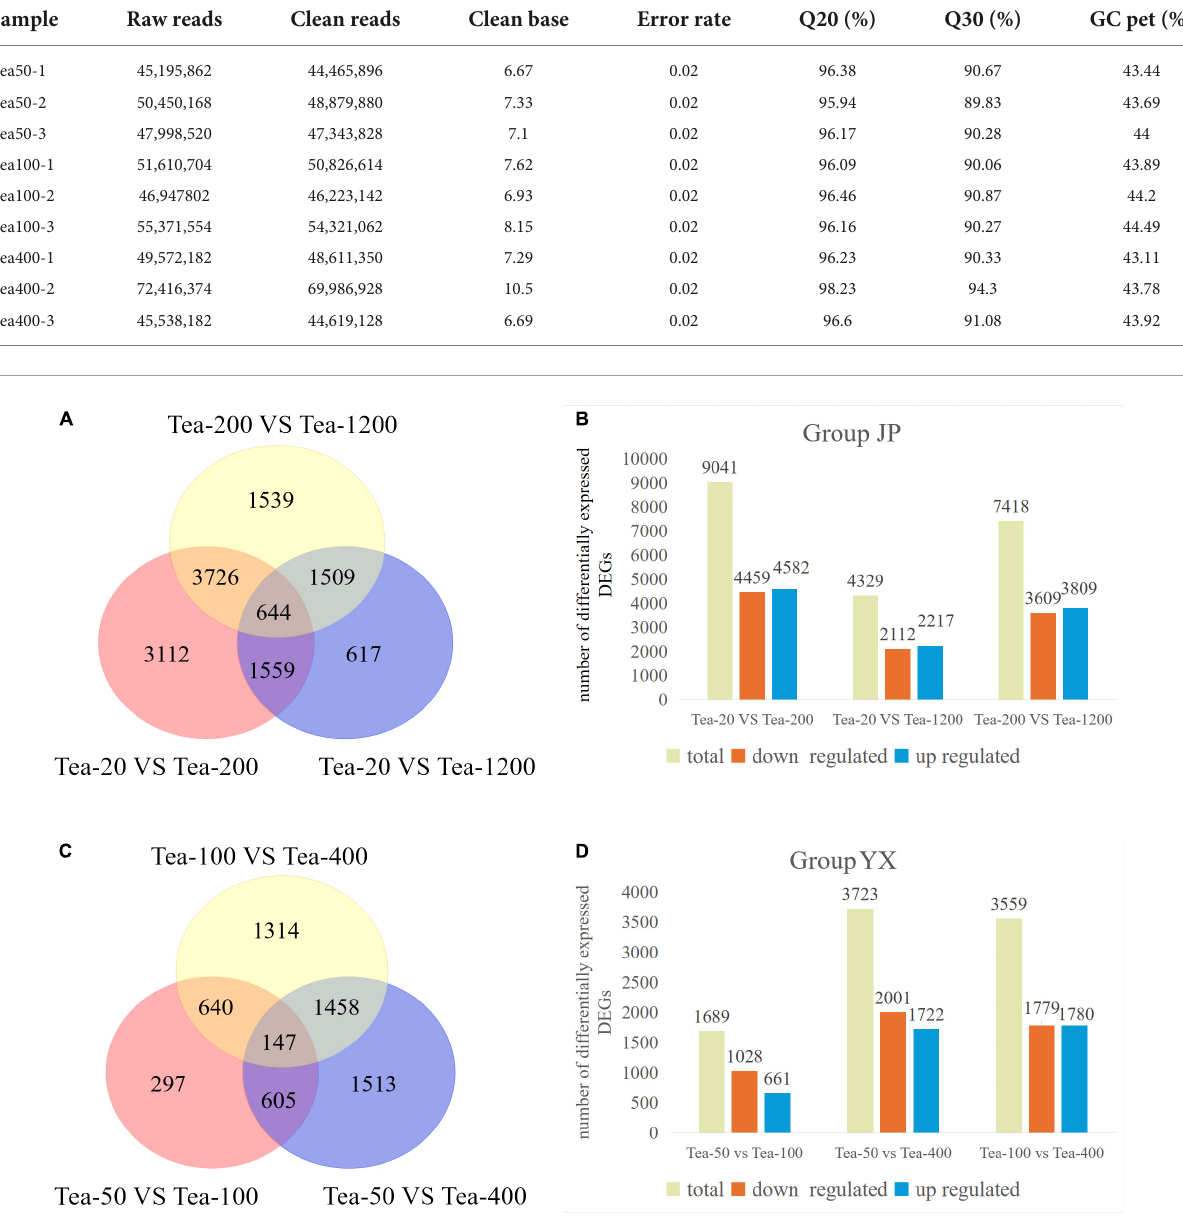
TABLE 3 Evaluation of tea transcriptome data of group YX.